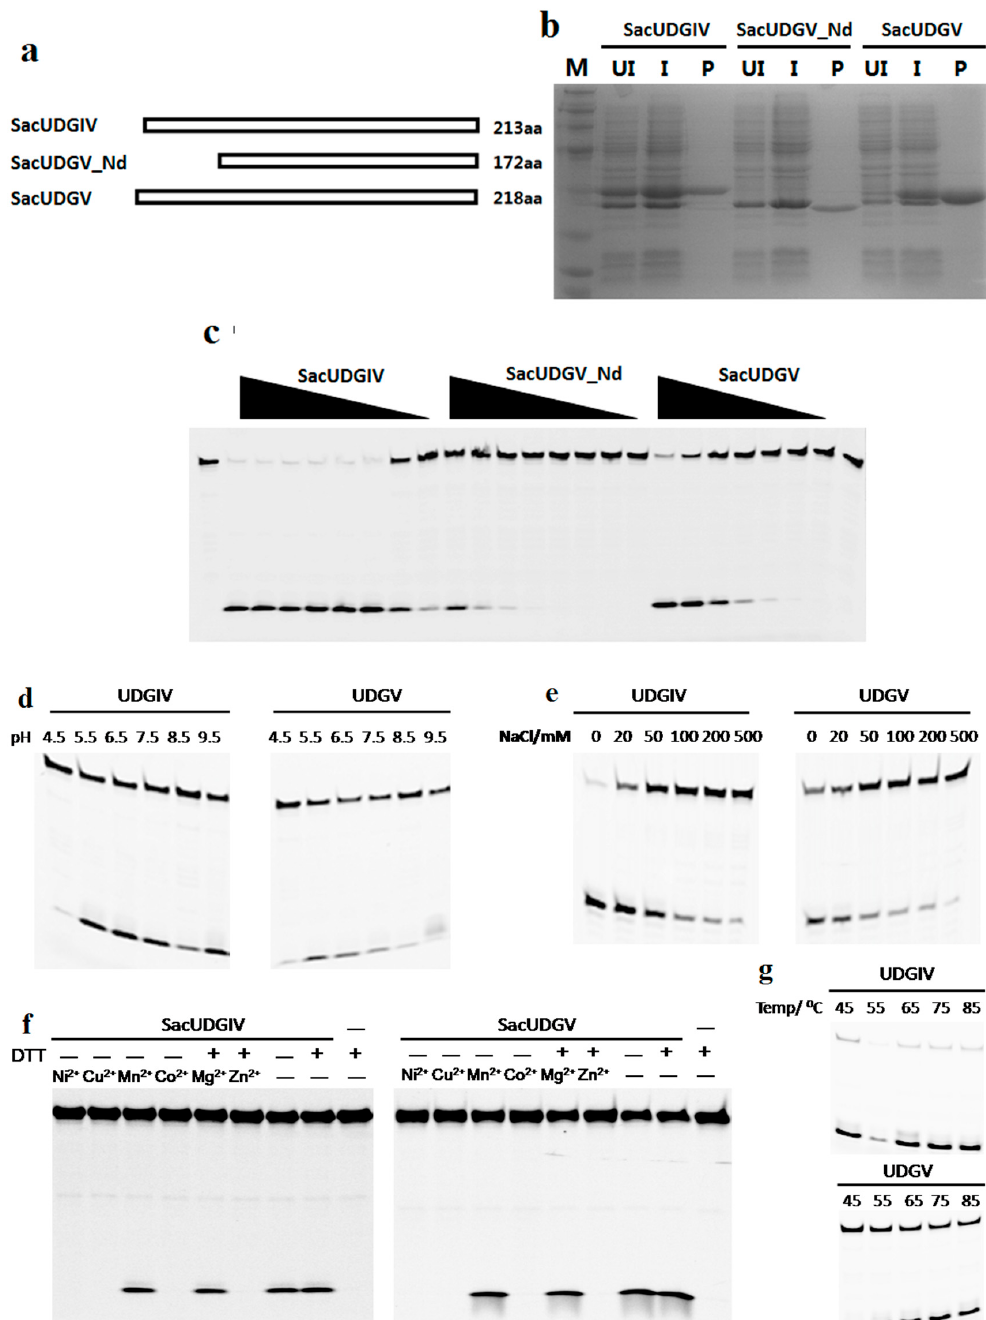
Figure 3. Uracil removal activities of SacUDGs. ( a ) Diagram of three UDGs from S. acidocaldarius ; ( b ) 15% SDS-PAGE analysis of recombinant SacUDGs recovered from induced E. coli extracts. The gel was stained with Coomassie blue R-250. Lane M: molecular weight marker; lane UI: uninduced E. coli total proteins; lane I: induced E. coli total proteins; lanes P: purified recombinant protein. ( c ) Removal of dU from single ‐ stranded DNA by SacUDGs. Approximately 300 ng SacUDGs were diluted in two ‐ fold and incubated with 0.1 μ M ss DNA for 15 min at 50 °C. Effect of pH value ( d ), NaCl concentration ( e ), divalent ions ( f ), and reaction temperature ( g ) on dU removal by SacUDGs. During optimization of reaction conditions about 1 ng SacUDGIV or 10 ng SacUDGV and 0.1 μ M dU ‐ carrying single ‐ stranded DNA were incubated at 50 °C for 15 min in assay buffer with various pH value, ion strength, or divalent ions. The reactions were performed at different temperatures for 15 min in an optimal assay buffer.